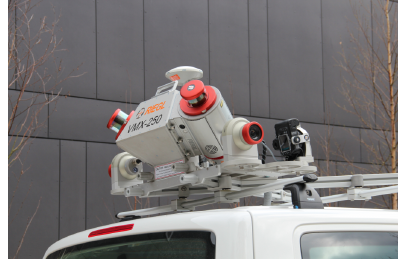
Figure 1. Mobile mapping system - Riegl VMX-250